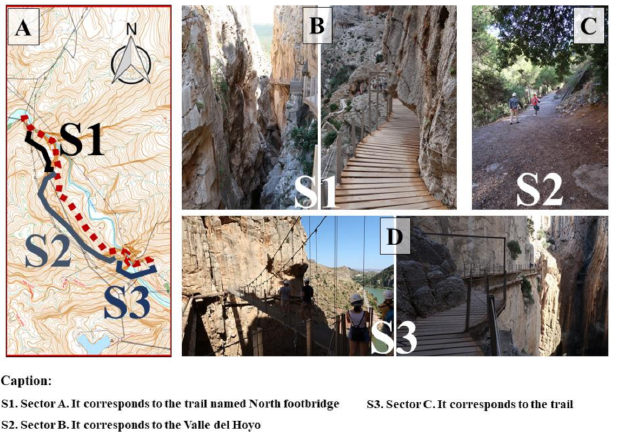
Figure 1. Location and sectors of the CR natural path. ( A ) Route of the El Caminito del Rey (CR) trail ( B ) Sector A; ( C ) Sector B; ( D ) Sector